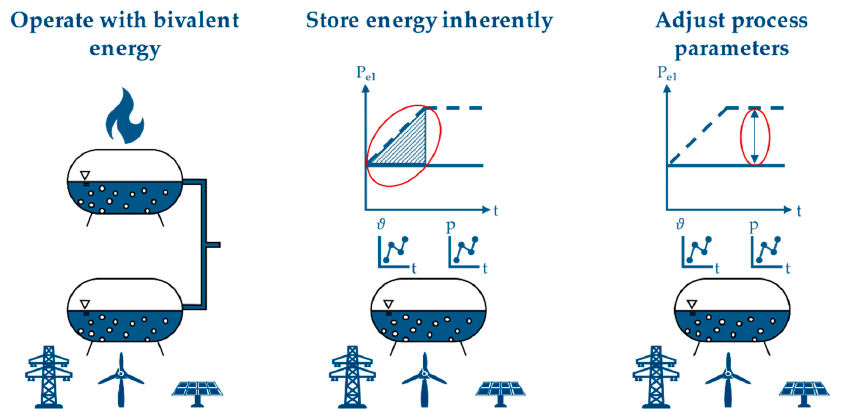
Figure 1. Direct energy-flexibility measures for industrial steam supply systems.